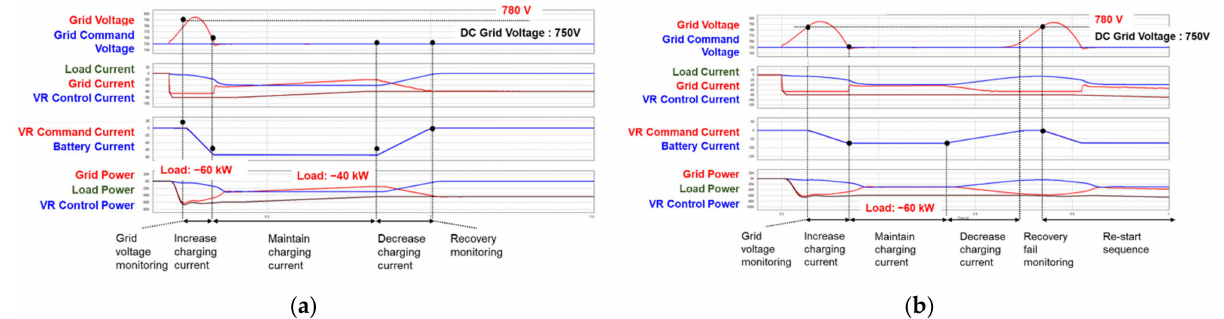
Figure 12. Simulation results of the proposed DC bus voltage regulation method at overvoltage con- dition: ( a ) when high power generation is successfully eliminated; ( b ) when high power generation is not